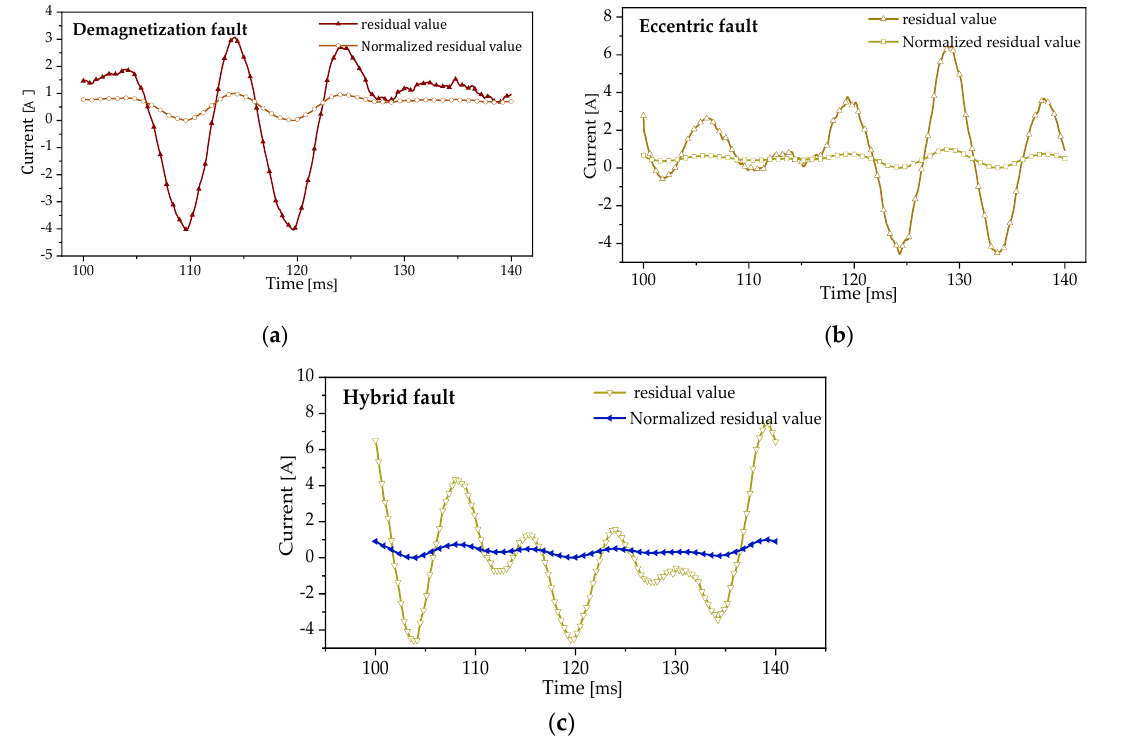
Figure 5. Residual and normalized MBCS of different faults. ( a ) Demagnetization fault, ( b ) eccentricity fault and ( c ) hybrid fault.